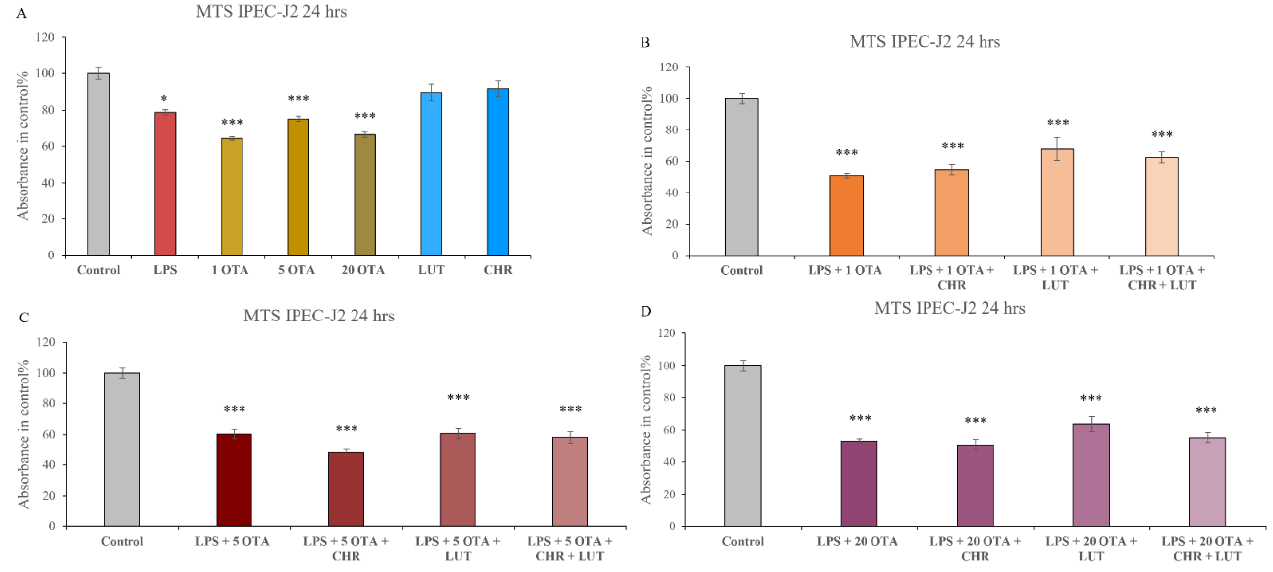
Figure 3. Cell viability determination. Changes in IPEC-J2 cell viabilities were detected after 24 hrs of administration of 10 µg/mL LPS, 1 µM OTA, 5 µM OTA, 20 µM OTA and in their combinations in the absence and in the presence of 1 µM CHR and 8.7 µM LUT. Data are shown as means of absorbances expressed in control % with standard errors of mean (SEM); n = 3-4 samples per group; * indicates p < 0.05, *** indicates p < 0.001 compared to controls.